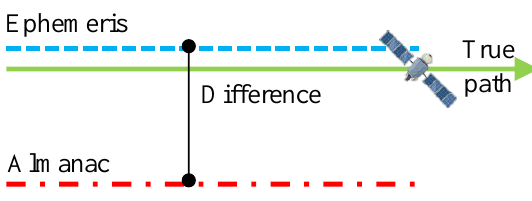
Figure 13. Schematic diagram of DQA4.